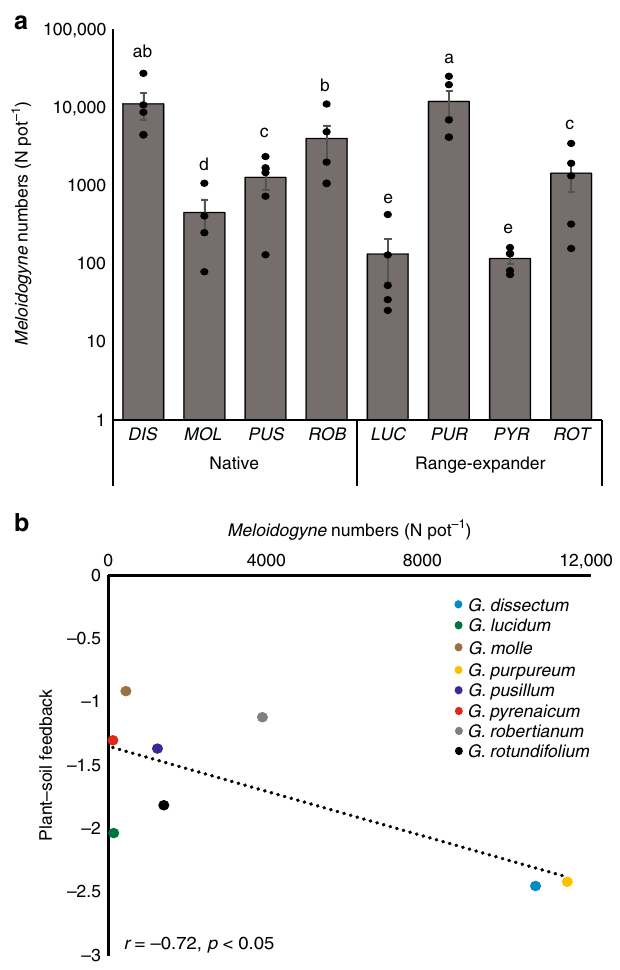
Fig. 5 Nematode reproduction. a Abundances of root-feeding nematode M. hapla on native (black) and range-expanding (red) Geranium species in a nematode reproduction experiment ( N = 5 per species). Bars represent average nematode numbers ± SEs. Letters indicate the signi fi cant differences based on negative binomial GLM and post-hoc Wald ’ s tests. Note that the y -axis has a logarithmic scale. b Correlation between Meloidogyne abundances and plant – soil feedback (ln(biomass conditioned / biomass control ). A Pearson ’ s correlation test was applied to evaluate the correlation. Pearson ’ s correlation coef fi cients r and p -values of Pearson ’ s correlation tests are shown. Source data are provided as a Source Data fi